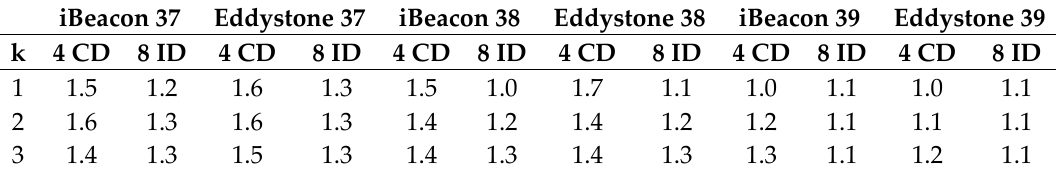
Table 3. Accuracy (m) for all protocols-channels and Euclidean distance, taking 4 cardinal directions (CD) and 4 cardinal directions + 4 intermediate directions (ID) in the calibration phase and in a random orientation in the positioning